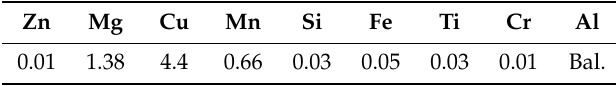
Table 1. Chemical composition of the AA2524 alloy